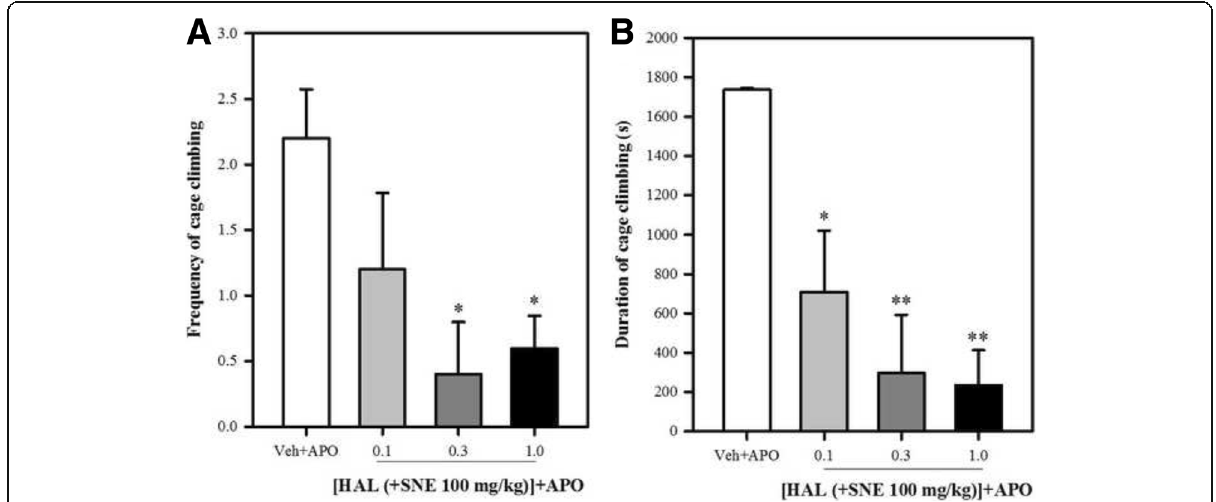
Fig. 9 Effect of haloperidol (HAL) when combined with SNE and vehicle on the total frequency ( A ) and duration ( B ) of cage climbing of mice, 30 min post apomorphine (APO) (2 mg/kg, i.p) treatment. Data are mean ± SEM ( n = 5). * P ≤ 0.05, ** P ≤ 0.001 compared with vehicle group (one-way ANOVA followed by a Dunnett ’ s multiple comparison post hoc test)